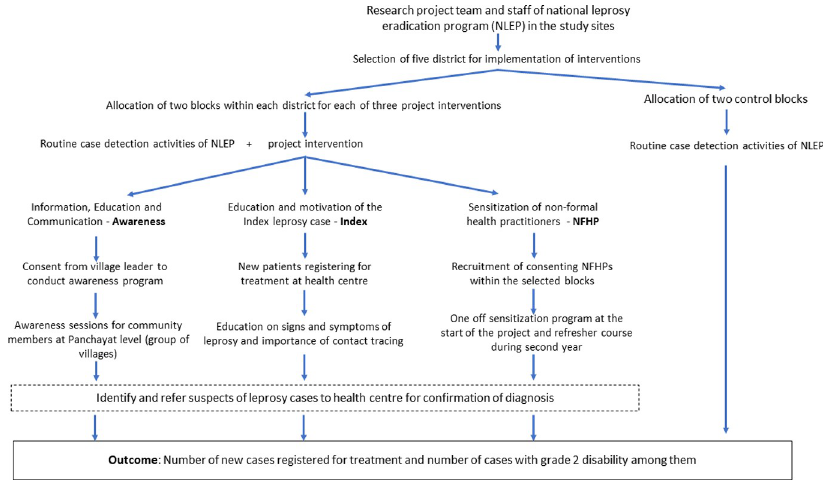
Fig 1. The flow diagram of study